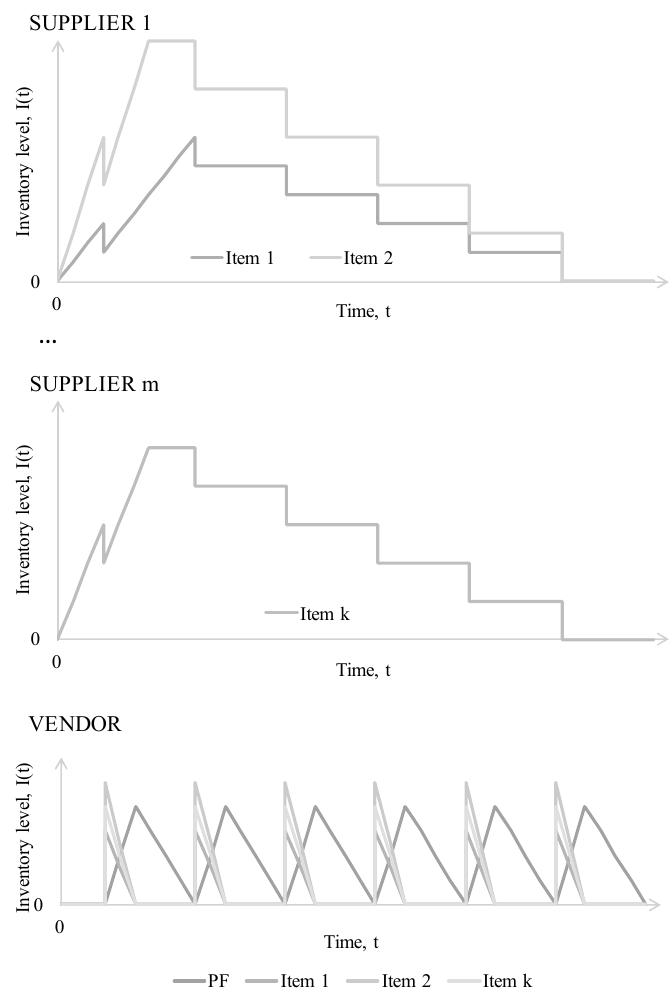
Figure 3. The inventory behavior for the suppliers and the vendor.